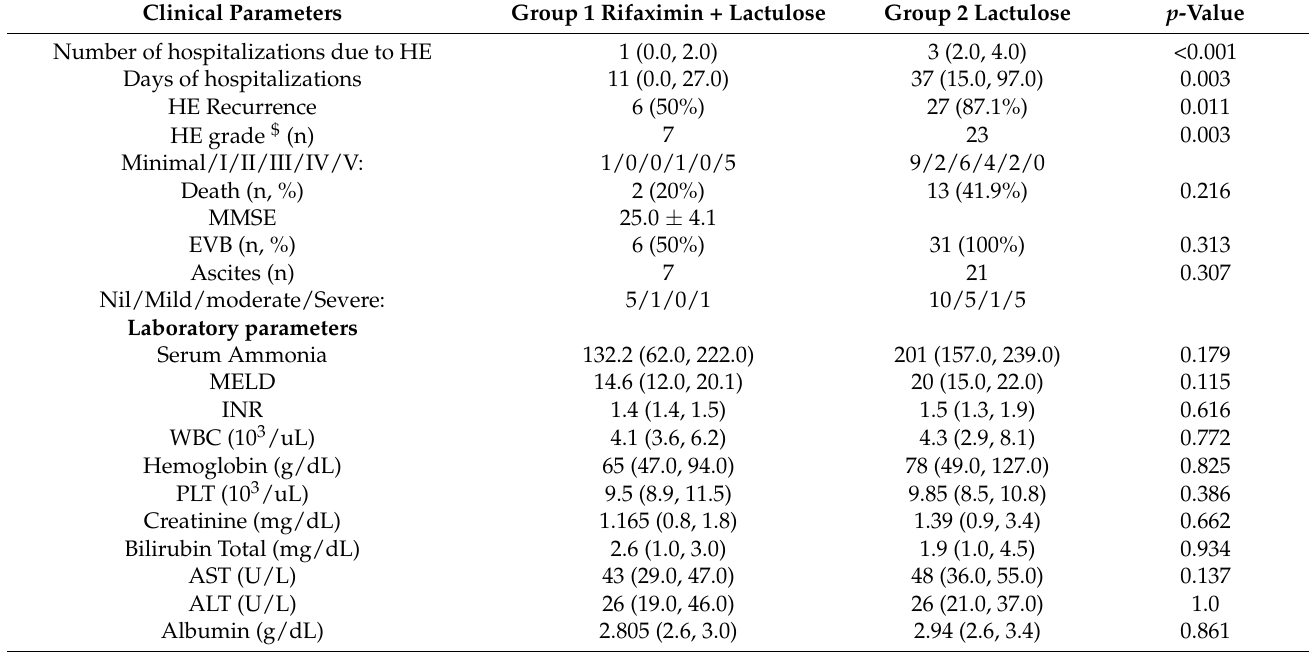
Table 3. Comparisons of clinical outcomes and laboratory parameters between groups after one-year follow-up. Clinical Parameters Group 1 Rifaximin + Lactulose Group 2 Lactulose p -Value 1 (0.0,